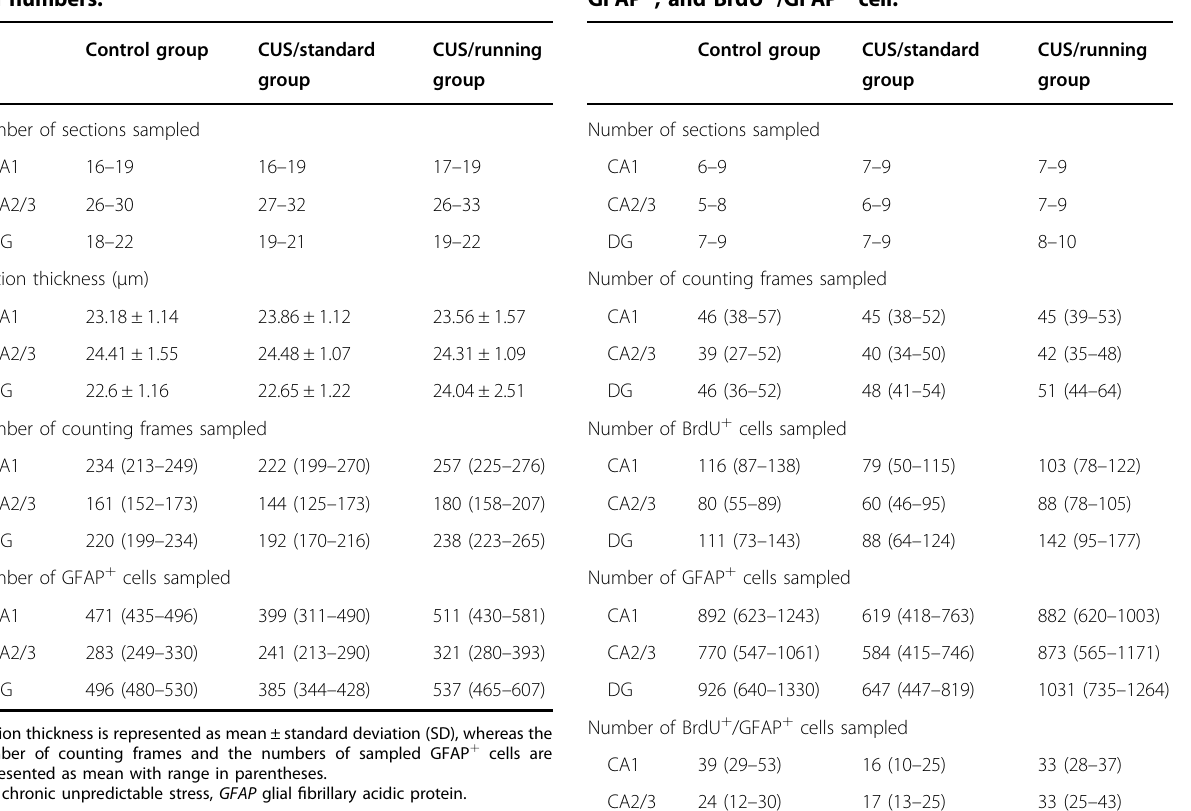
Table 2 Sampling scheme for the estimation of GFAP + cell numbers.